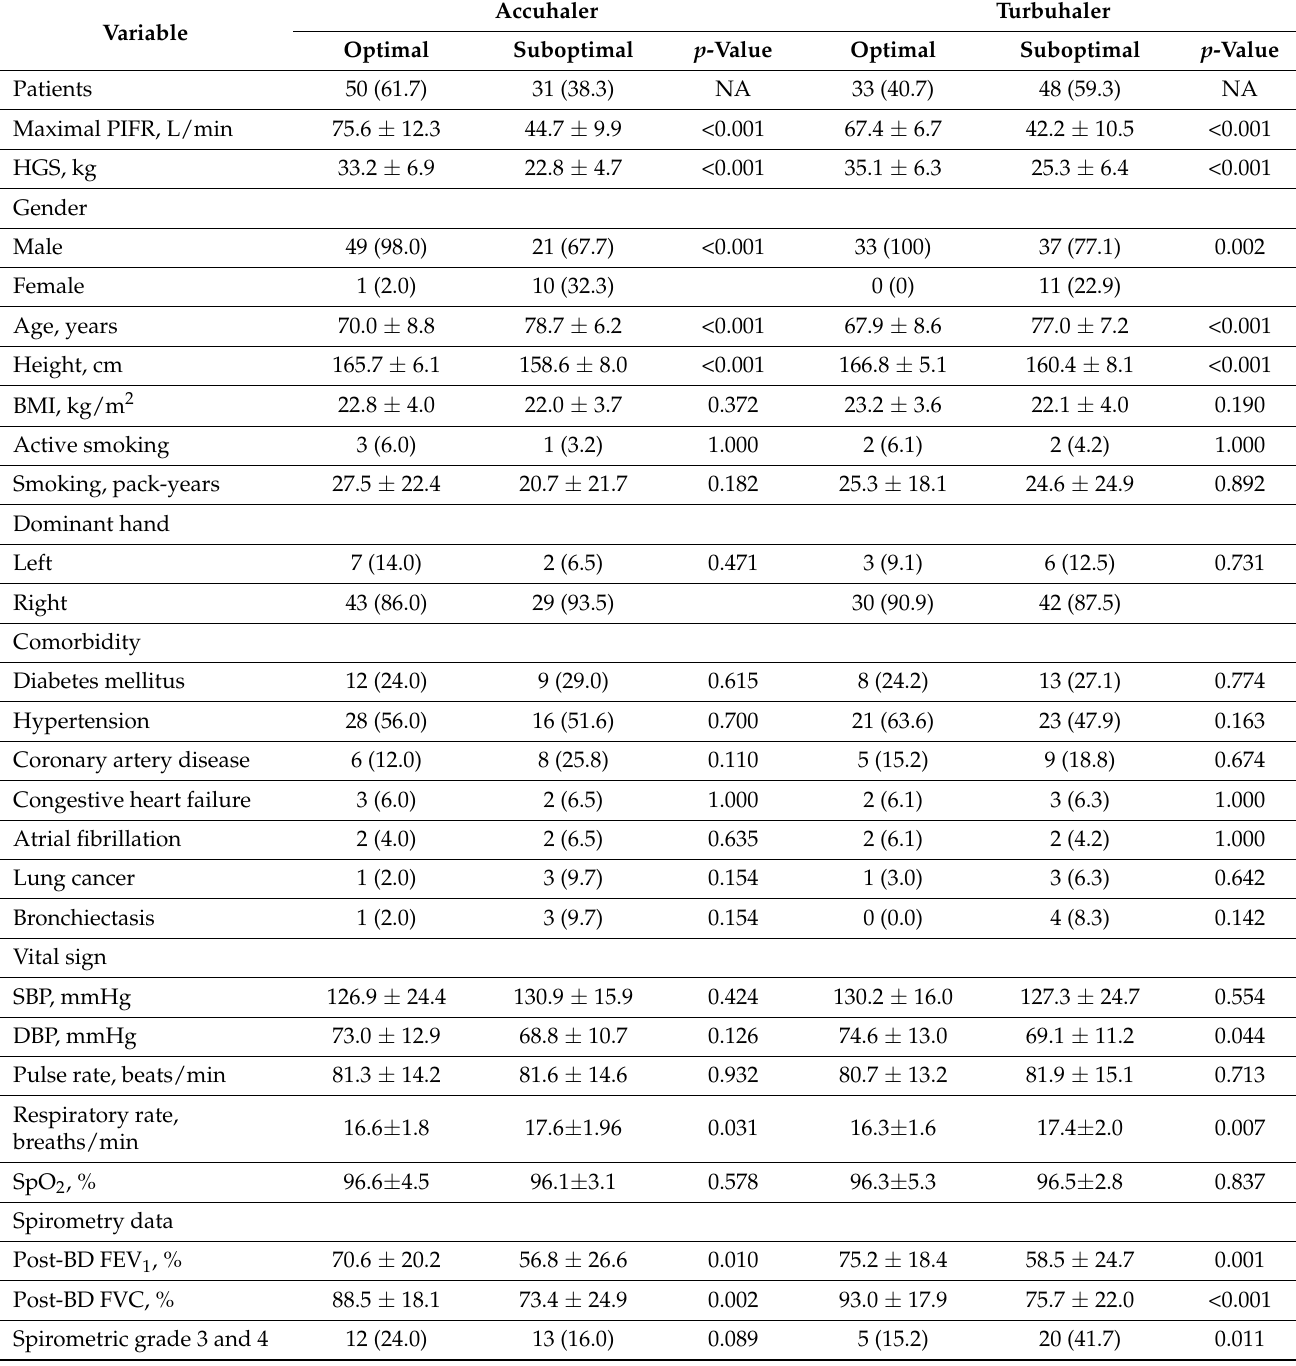
Table 2. Comparison of characteristics of clinically stable COPD patients between the optimal and the suboptimal PIFR groups for Accuhaler and